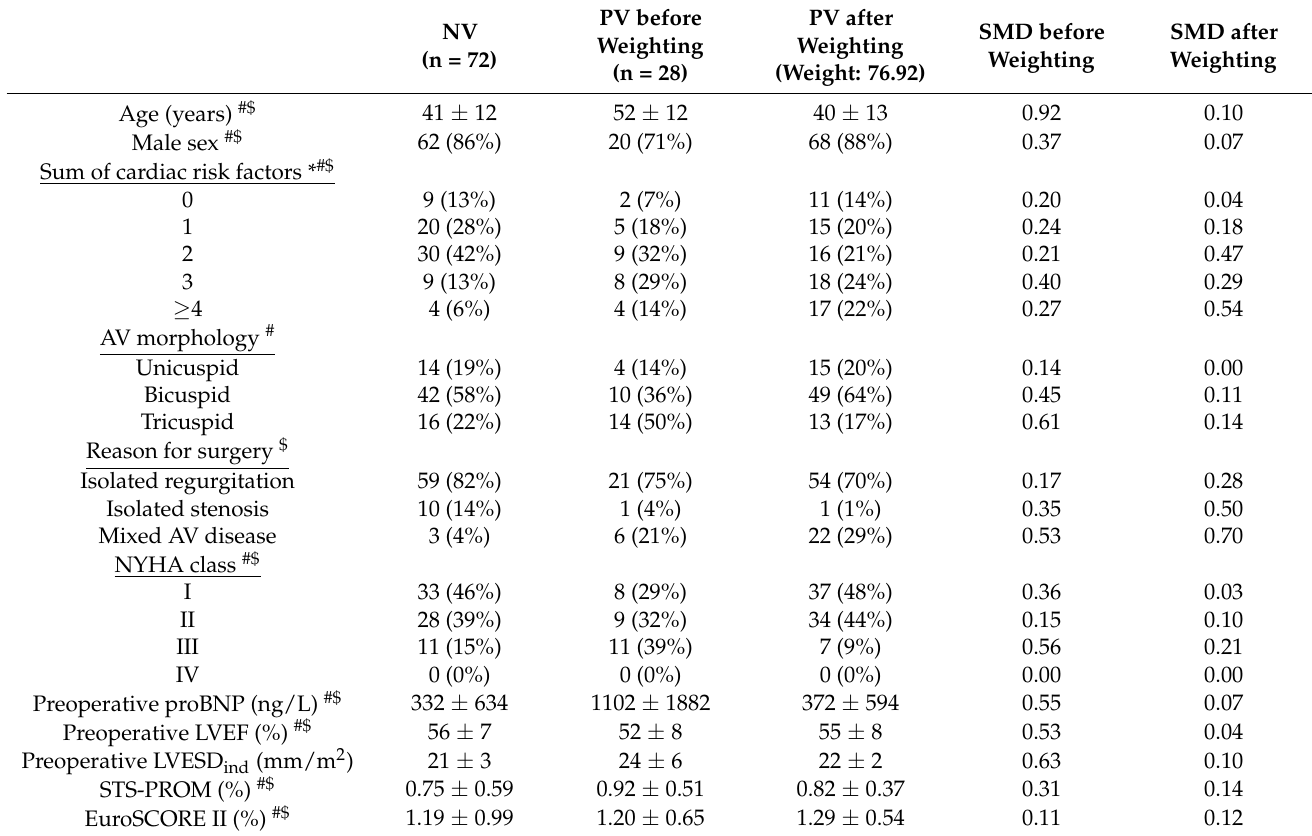
Table 1. Baseline patient characteristics.